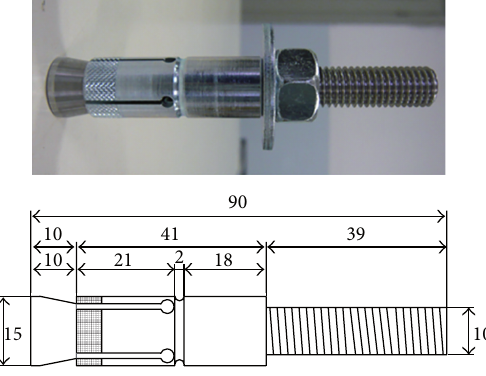
Figure 4: The new B15G